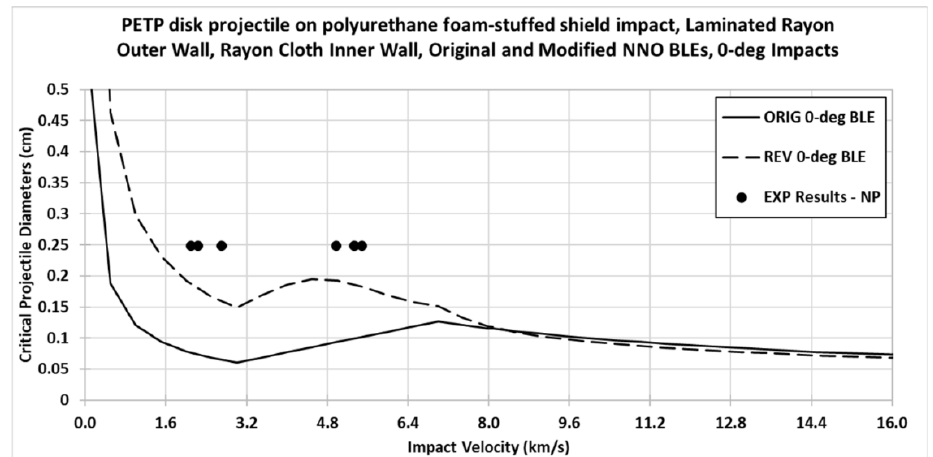
Figure 3. Comparison of Original and Modified NNO BLEs against P/NP data in [8] for Dual-Wall Systems with Rayon Outer and Inner Walls.